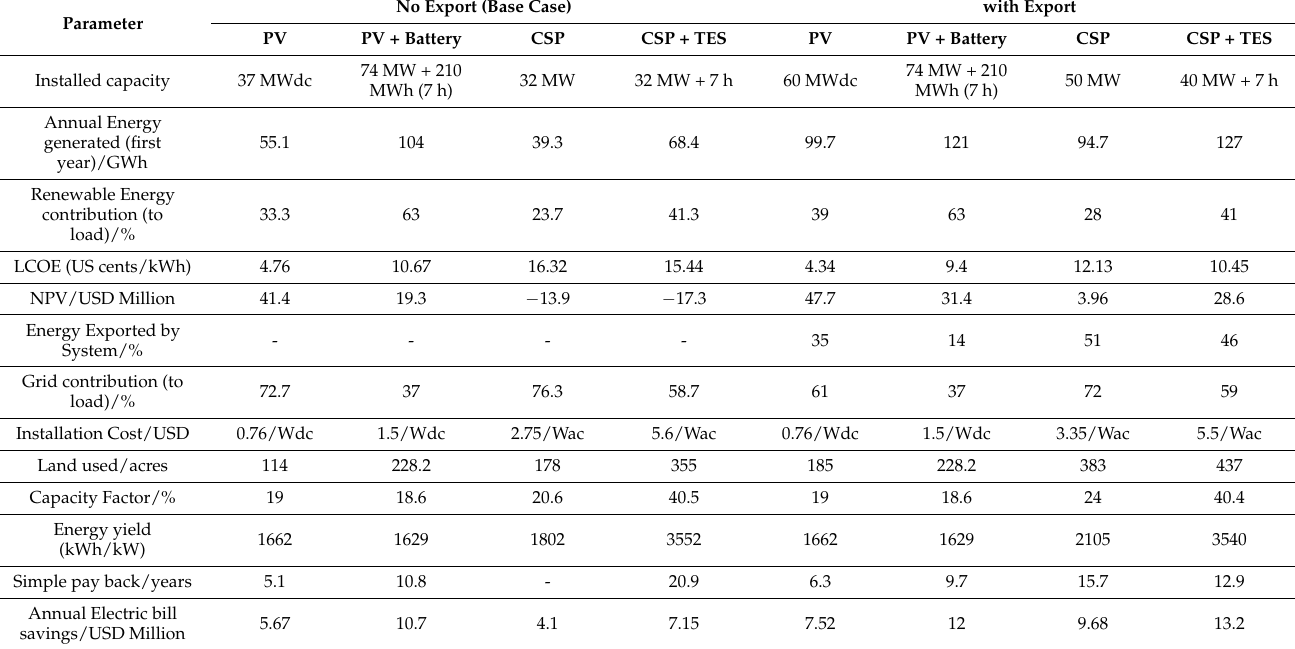
Table 19. Summary of key